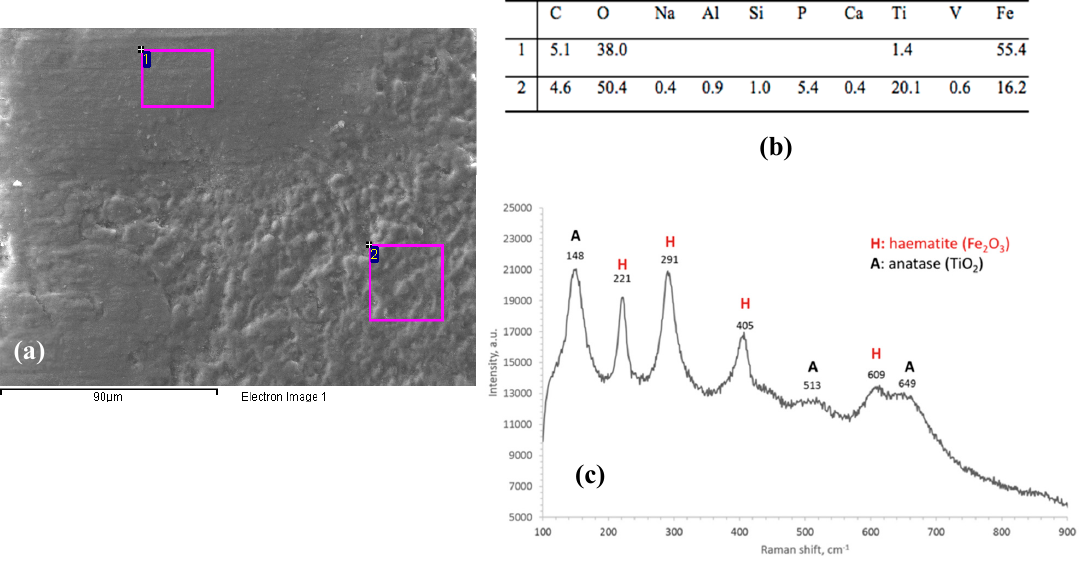
Figure 11. ( a ) representative SEM image of transfer layers on the surface of wear scars (single layer PN, 5 N) with ( b ) EDS data (wt.%) and ( c ) micro-Raman spectrum taken in area 1 of ( a ), showing that the thicker areas of the transfer layer mostly consist of haematite (Fe 2 O 3 ).